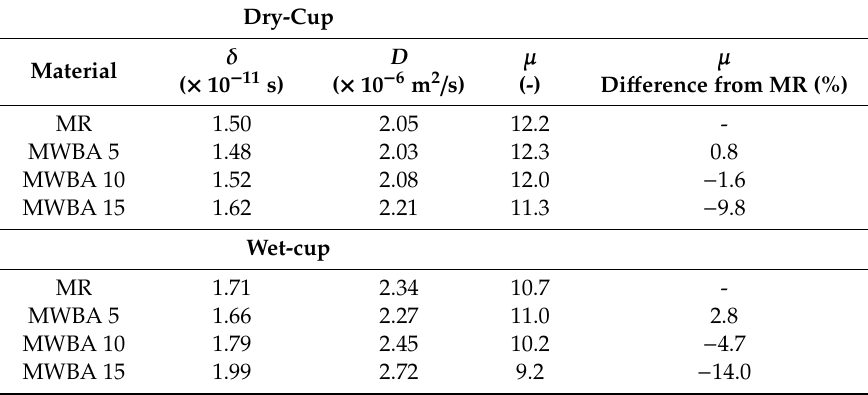
Table 12. Water vapor transmission